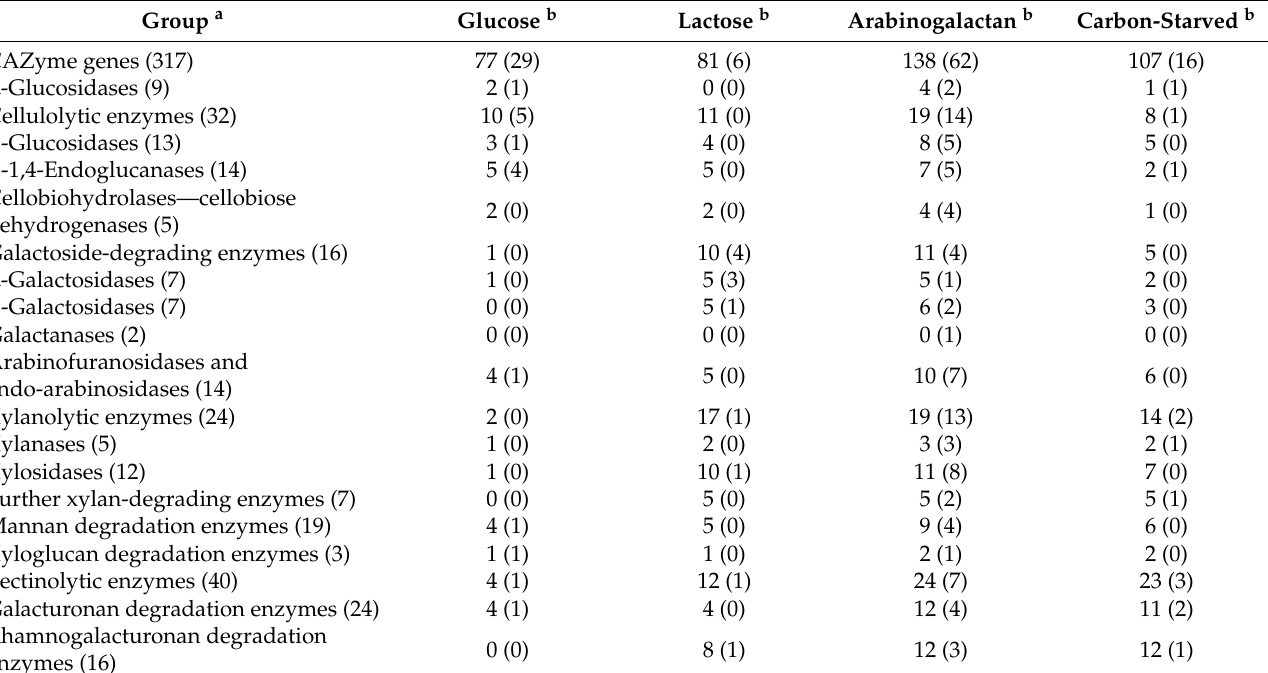
Table 4. Transcriptional behavior of CAZyme genes in the four types of A. nidulans cultures.